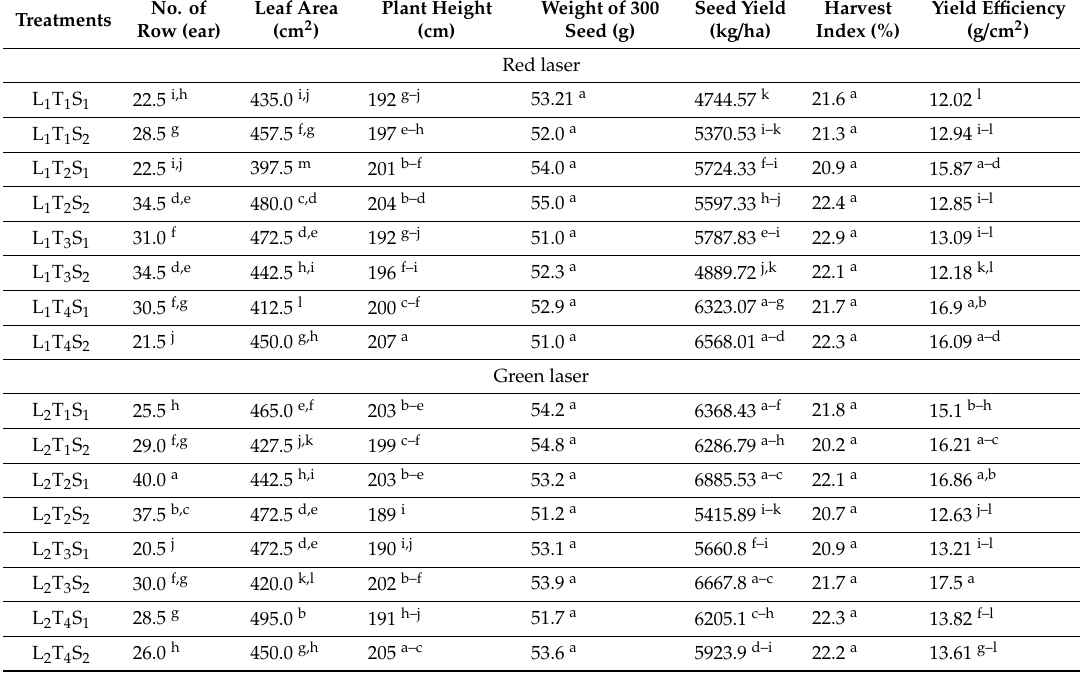
Table 2. Growth and yield component of maize seeds pretreated with lasers of di ff erent wavelength and exposure